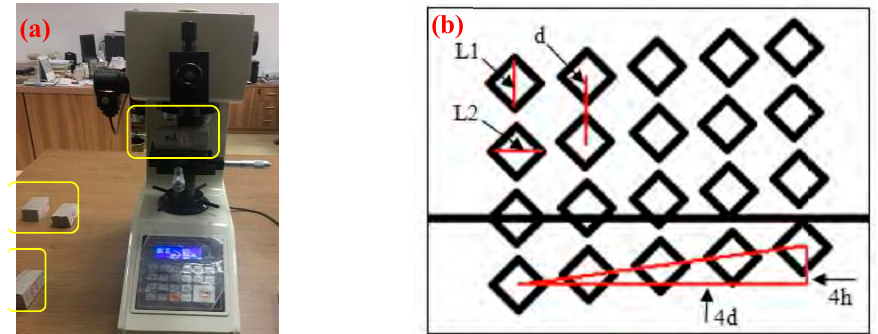
Figure 4. ( a ) The microhardness toughness testing setup (yellow squares: split specimen blocks after surface polishing by 240, 320, 600, and 1200 mesh sand papers, polishing cloth, and polishing agent in sequence; ( b ) schematic claim of microhardness point